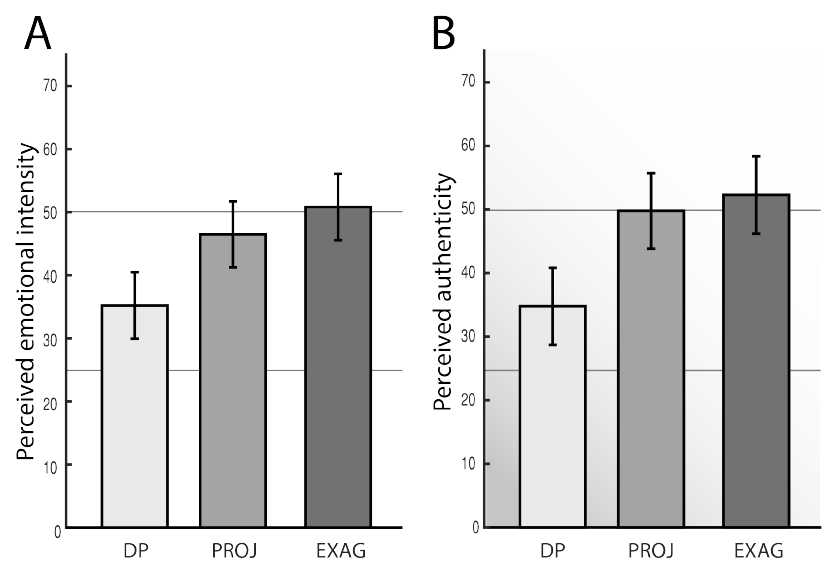
Figure A2. Impact of the expressiveness on ( A ) the perceived emotional intensity; ( B ) the perceived authenticity (deadpan: DP, projected: PROJ, and exaggerated: